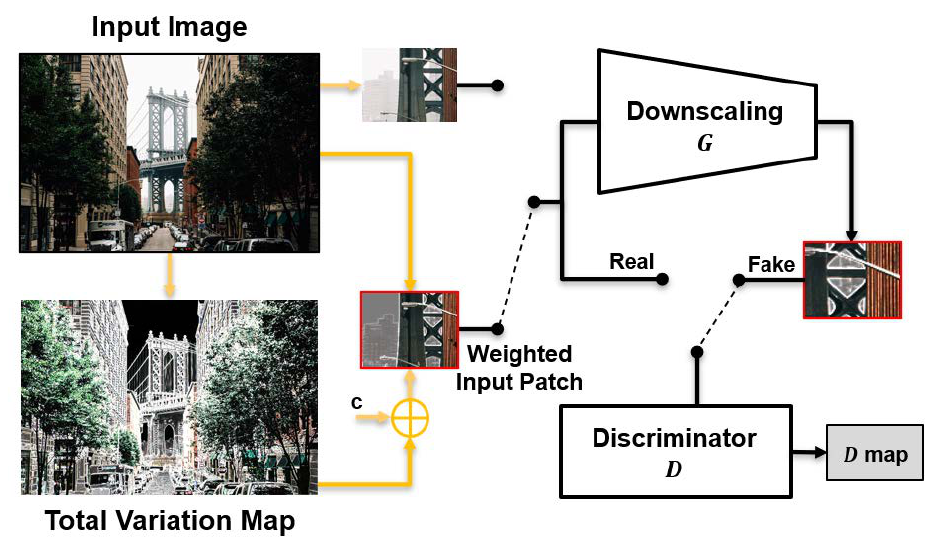
Figure 4. Structure of